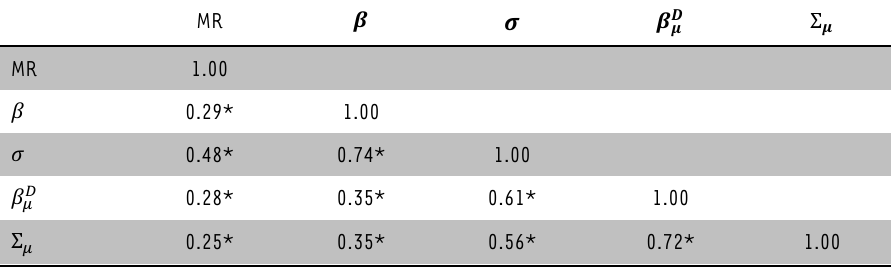
TABLE 2: Cross-sectional analysis - correlation matrix MR